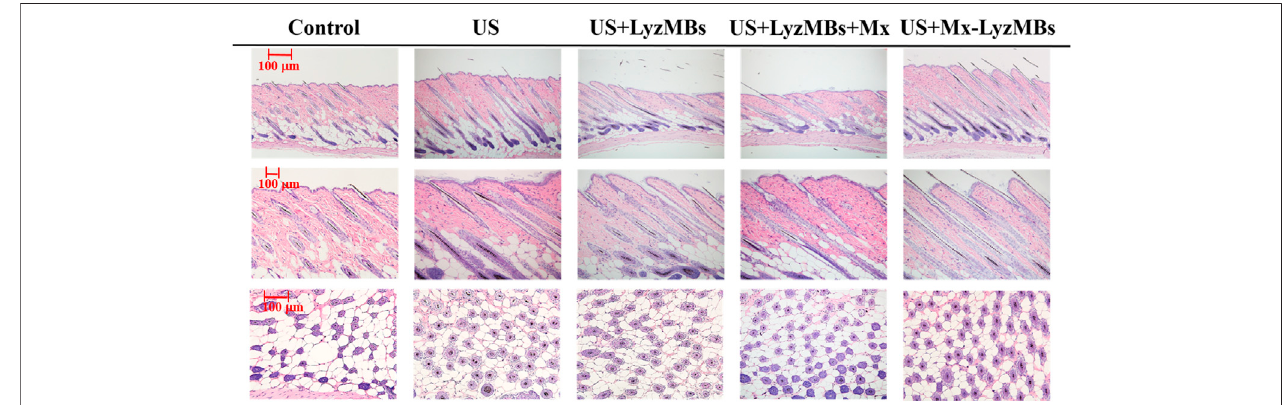
FIGURE9| Histologicalobservationsofhairfolliclesinmiceskin.Thedorsalskinsurfacesofthemicewereshaved,andthentestcompoundsandtreatmentswere topically applied for 3 weeks. Vertical (upper and middle panels) and coronal (lower panel) views of the hair follicles.